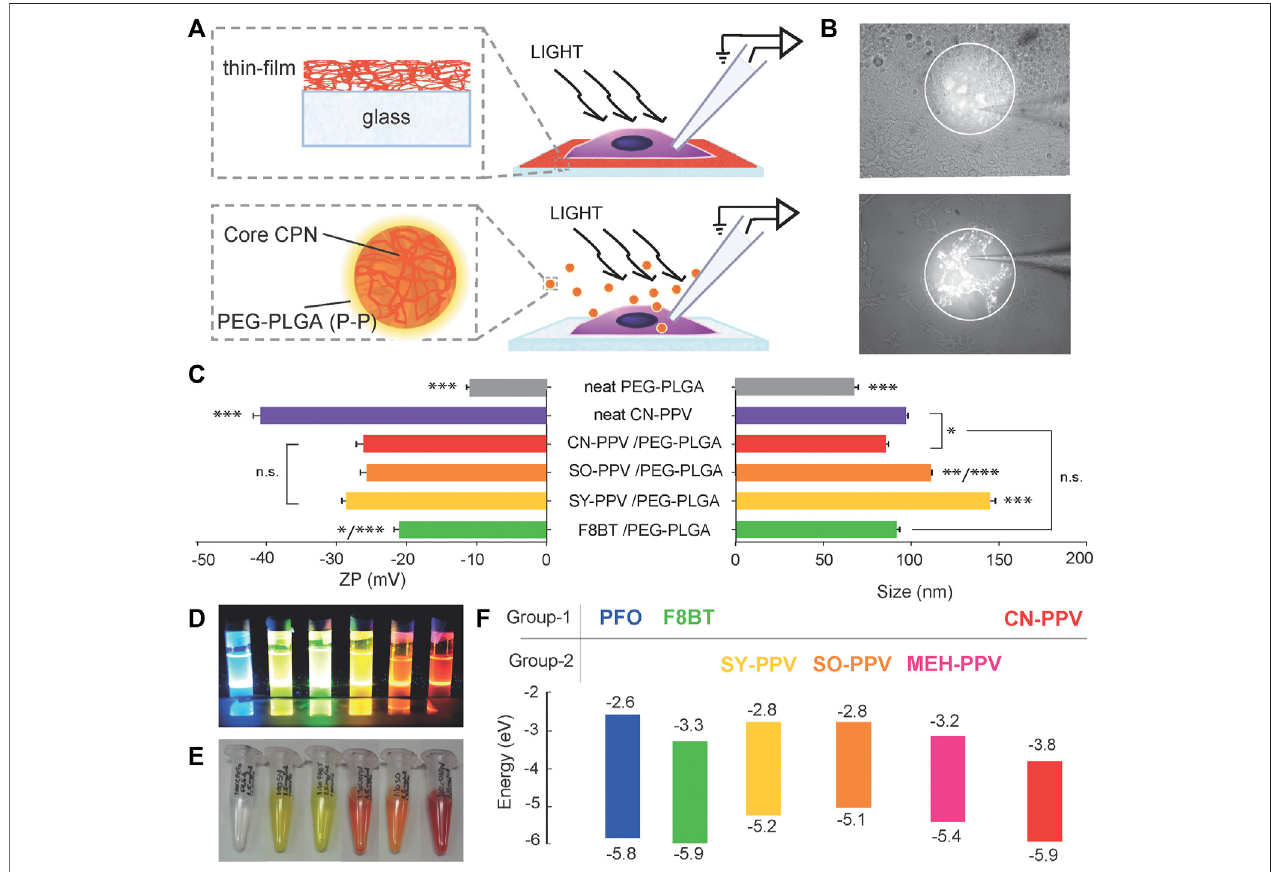
FIGURE 1 | Experimental and material overview for assessment of organic conjugated polymers in solid-state thin fi lms and nanoparticle dispersions with PEG 5k - PLGA 55k amphiphilic stabilizing agent. (A) Patch-clamp set-up with cells grown on top of conjugated polymer thin fi lms (top) or exposed to CNPs (bottom). (B) Representativeimagesofpatchedcellsduringphoto-irradiationofthin fi lms(top)andCNPs(bottom). (C) ZetapotentialandhydrodynamicdiametersofCNPs. (D) Leftto right:PFO,F8BT,SY-PPV,SO-PPV,MEH-PPV,andCN-PPVinTHFunderUV-lightillumination. (E) Lefttoright:100%PEG 5K -PLGA 55K ,F8BT,SY-PPV,CN-PPV, SO-PPV, and 100% CN-PPV CNPs in DI-water under ambient light. (F) Band gap energy (Eg) for F8BT and PFO and SY-PPV, SO-PPV, MEH-PPV, and